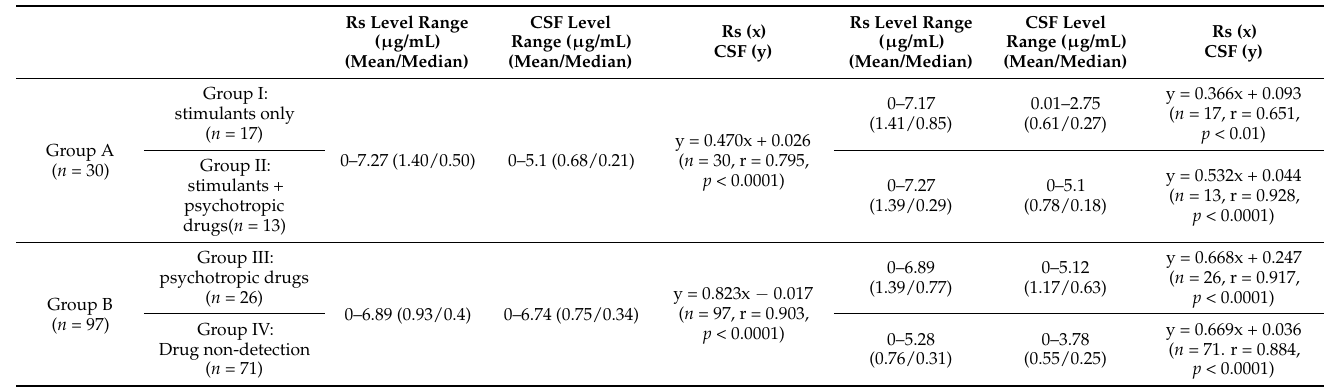
Table 1. Relationship between caffeine concentration in blood and that in CSF in each group ( n = 127).